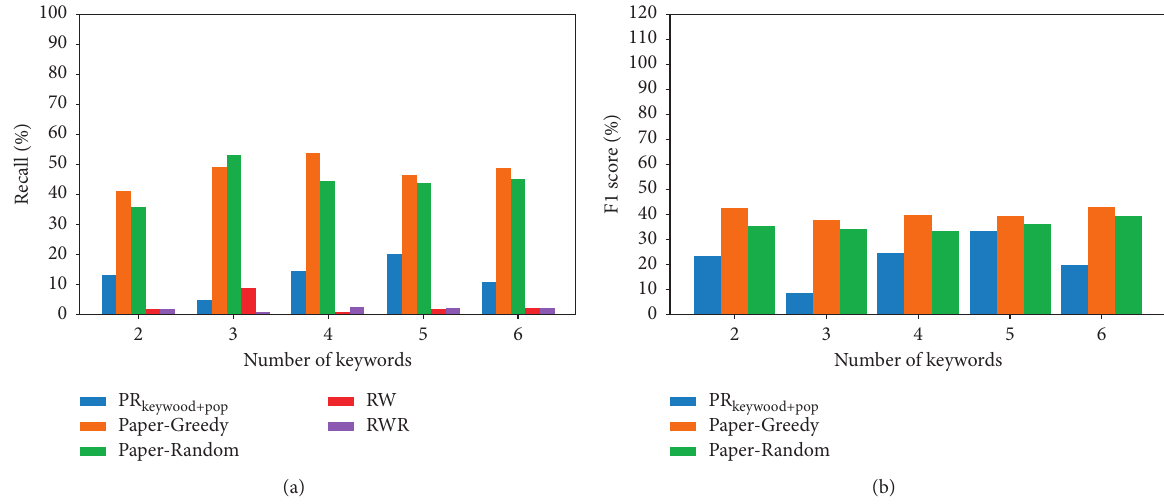
Figure 13: The recall rate and F1-score values of different approaches. (a) The recall in set C. (b) The F1 score in set